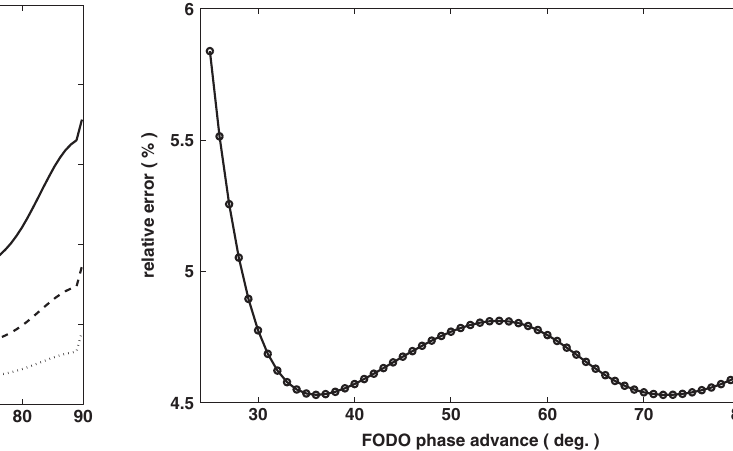
(or M ) plotted against cell FIG. 7. Simulated vertical emittance reconstruction error vs X Y cell phase advance, 5 wire scanners, 5% error on beam size